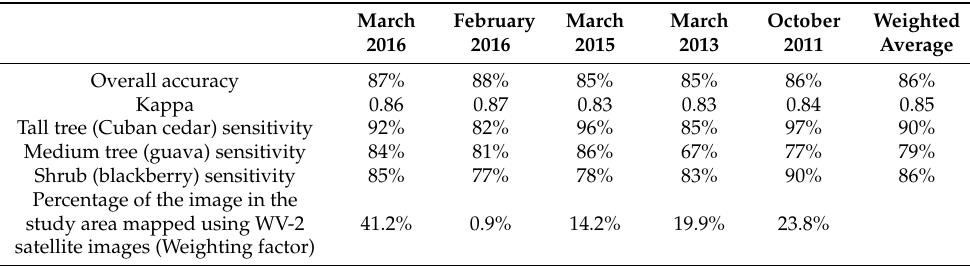
Table 1. Overall accuracies and Kappa obtained from confusion matrices calculated with the valida- tion points from the Random Forest (RF) model developed for each WV-2 satellite image, as well as the sensitivity of the three target species. Weighted averages were calculated using the percentage that each image occupies in the area mapped, using WV-2 images as the weighting factor. Complete confusion matrices are included in Appendix